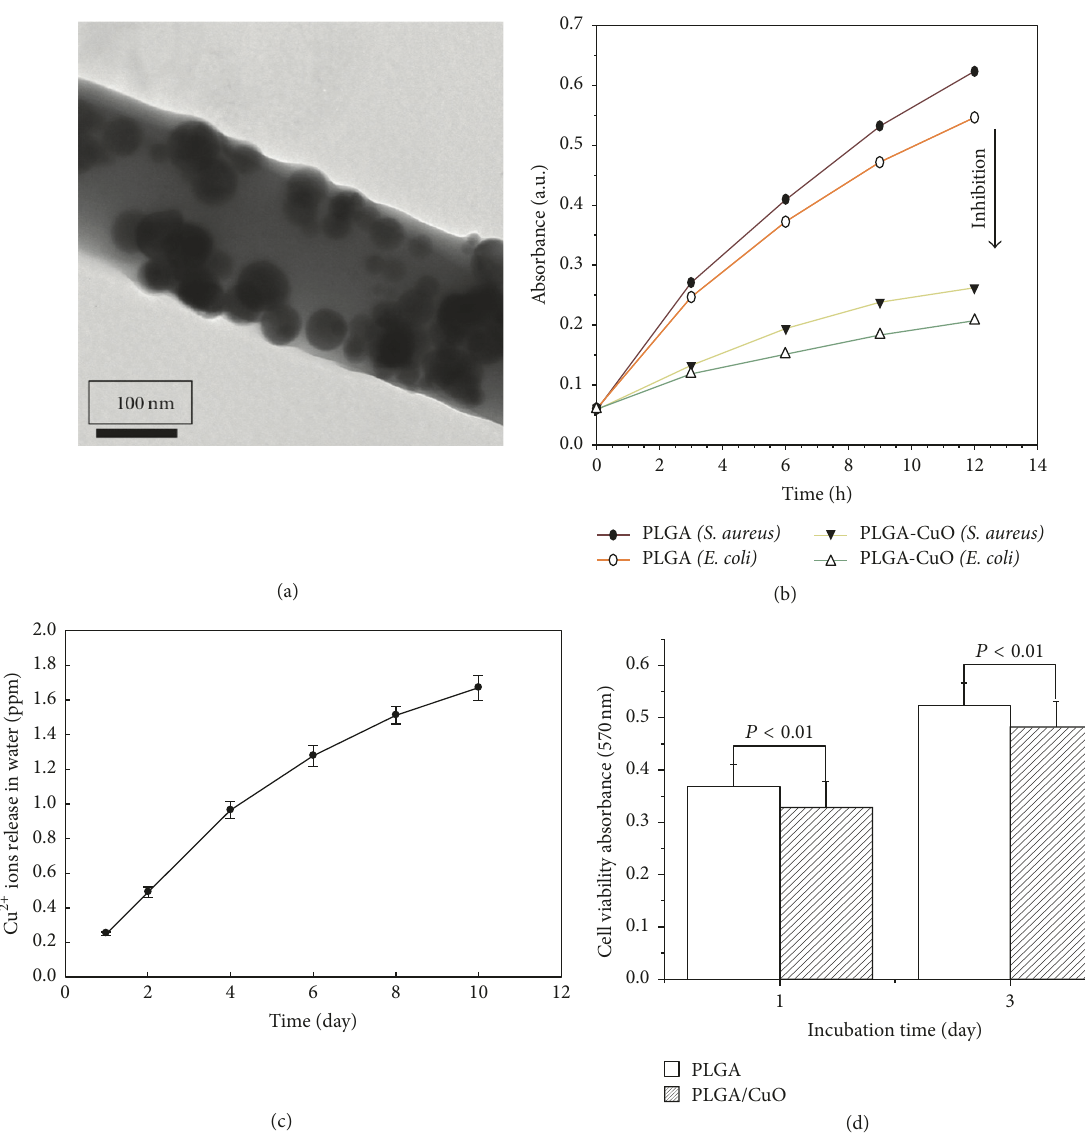
Figure 4: (a) CuO nanoparticles embedded in electrospun PLGA fibers, (b) inhibition of E. coli and S. aureus from PLGA and PLGA/CuO fibers, (c) release profiles of Cu 2+ ion in water, and (d) fibroblast cell viability study from PLGA and PLGA/CuO fibers [71] (figure